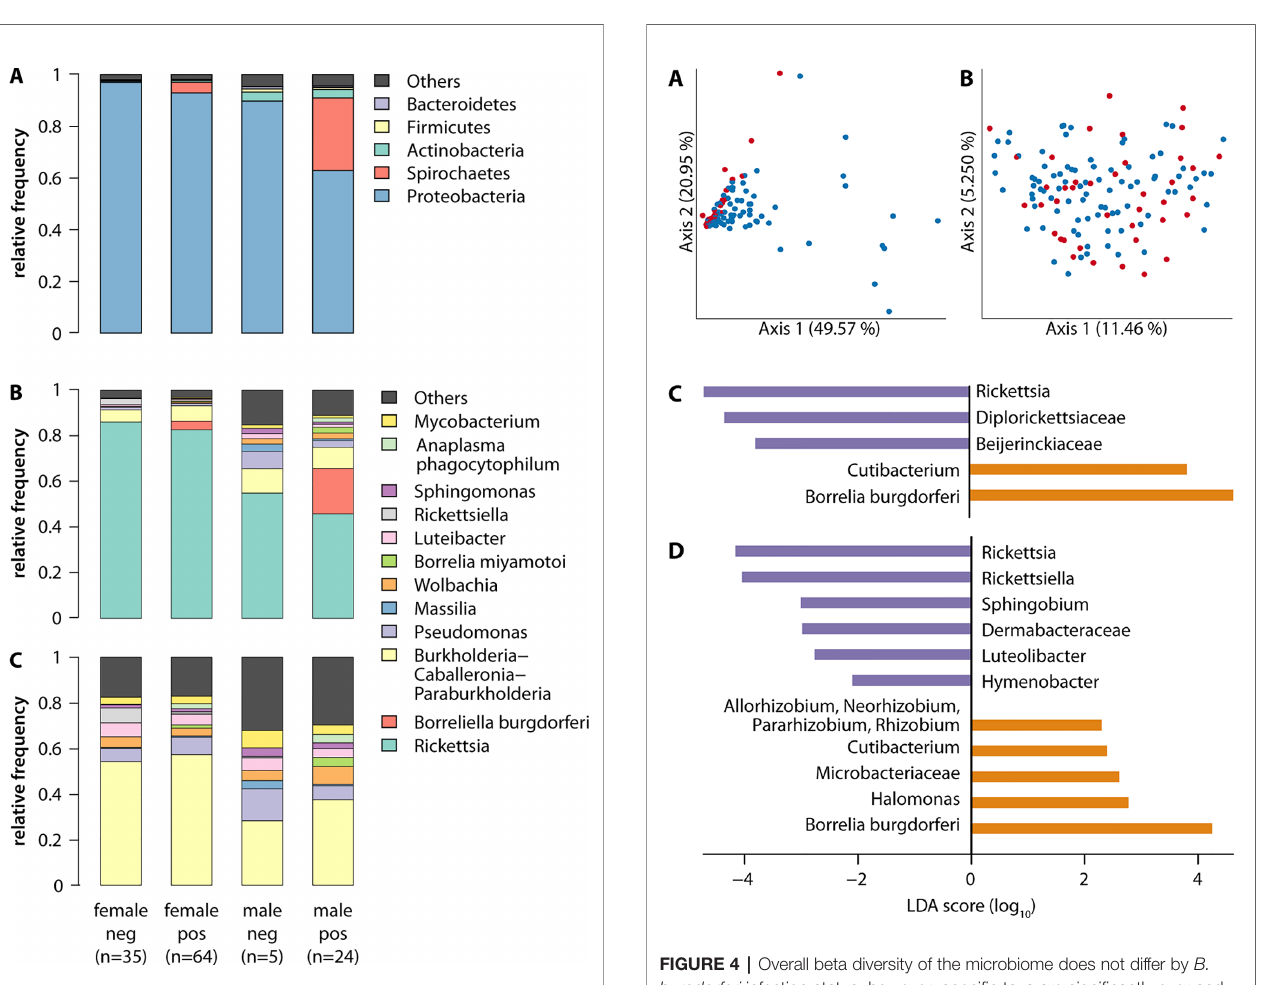
FIGURE 3 | Abundance of microbial taxa in male and female ticks with and without B. burgdorferi infection re fl ects the greater diversity of the male microbiome. (A) At the phylum level, B. burgdorferi is evident in the abundance of Spirochaetes in the infected ticks, and males have higher frequency non-Proteobacteria phyla, re fl ecting the greater diversity of their microbiome. Here, “ Others ” (grey) represents all reads unclassi fi able using the 16S SILVA reference database with a 99% identity cutoff. (B) The greater microbiome diversity in males, and higher abundance B. burgdorferi in infected males (19.89% vs 3.75%; t-test = 4.0505, p = 0.00048), is also evident at the level of genera. Females have a higher frequency of Rickettsia , potentially due to the high abundance of that genus in the ovaries(Noda et al., 1997). (C) The greater diversity of male microbiome on the genera level persists even when both B. burgdorferi and Rickettsia are removed from the analysis.